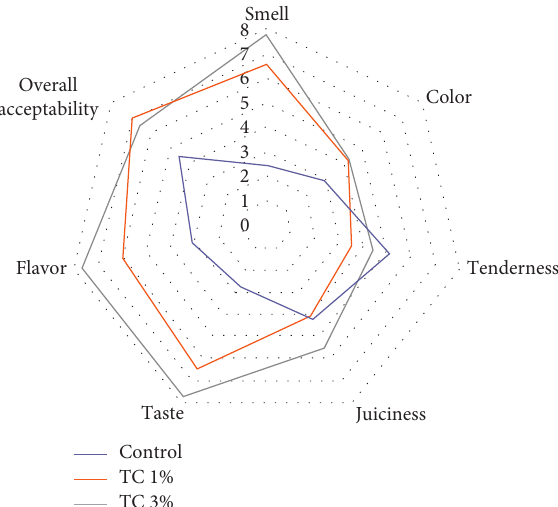
Figure 5: Sensory assay of meat samples treated with T. capitatus EO.